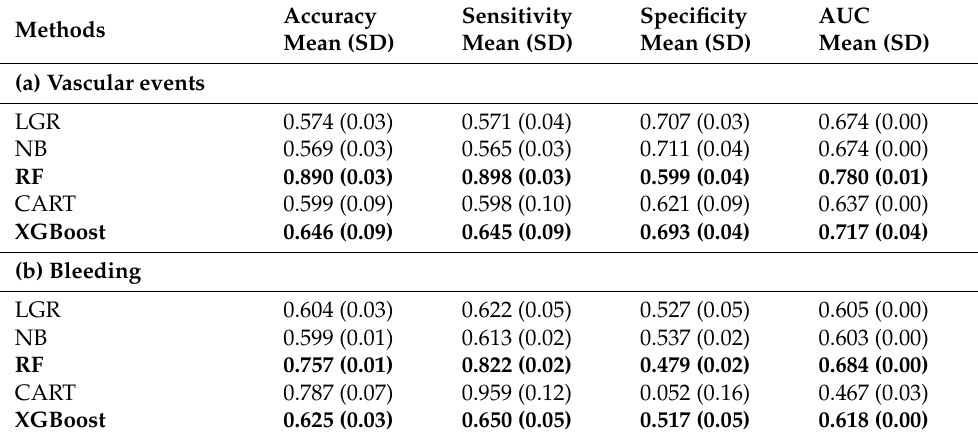
Table 4. Performance of the four machine learning methods in predicting (a) vascular events and (b) bleeding.